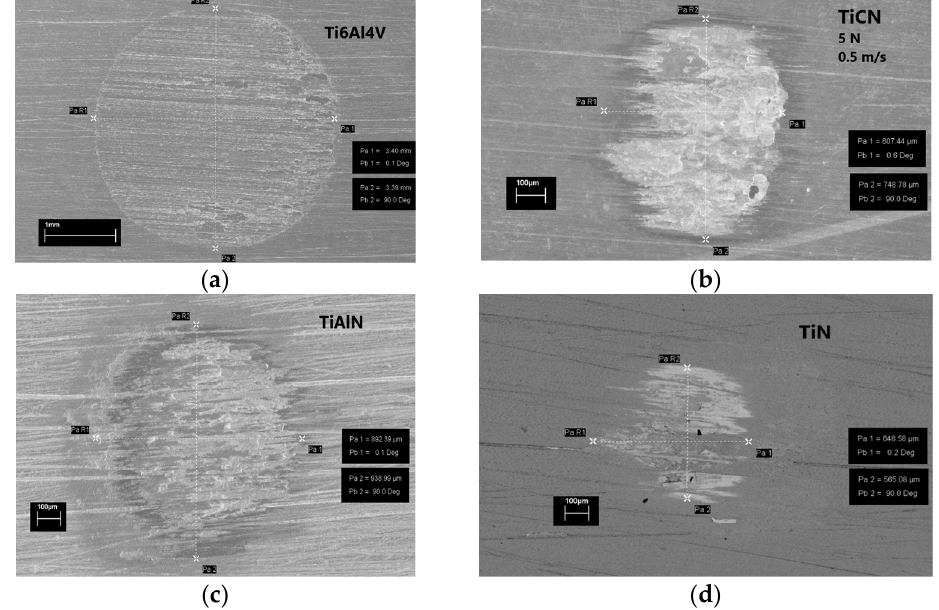
Figure 12. Wear track widths determined by scanning electron microscopy at the same load and sliding rate; ( a ) Ti6Al4V, ( b ) TiCN, ( c ) TiAlN, ( d ) TiN.